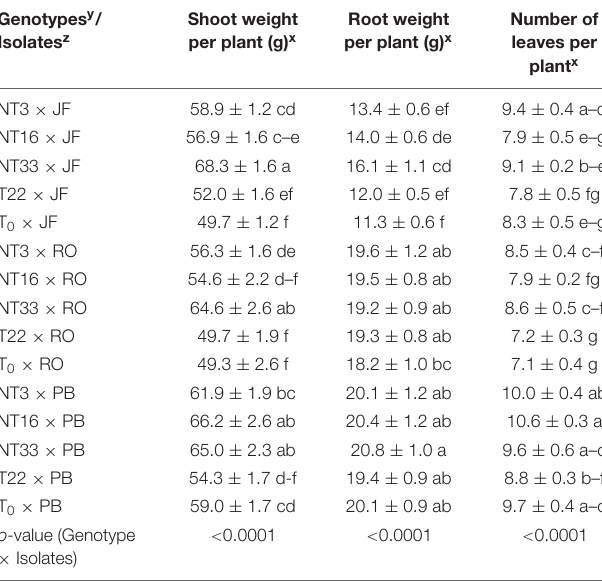
TABLE 1 | Effect of four Trichoderma isolates on fresh shoot weight, fresh root weight, and number of leaves on three tomato genotypes under water deficit stress conditions x .